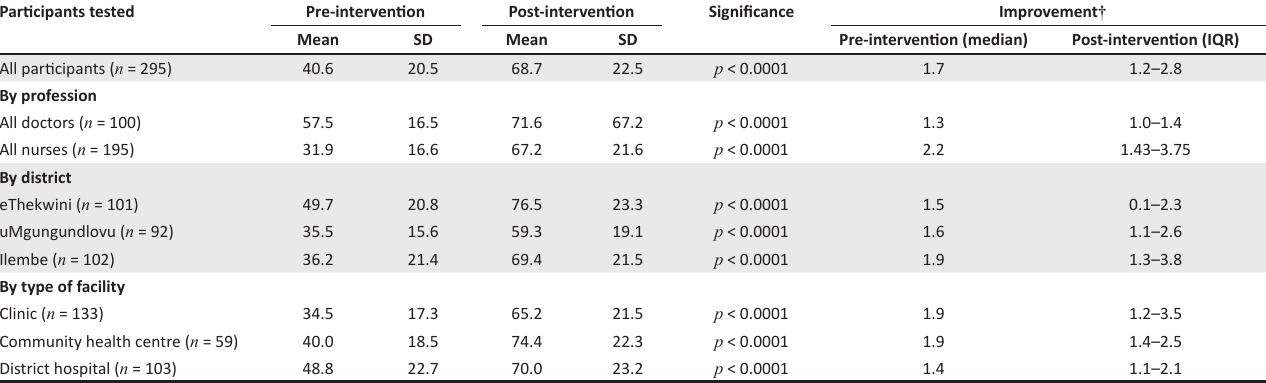
TABLE 1: Performance on the test measured before and after a teaching intervention. Participants